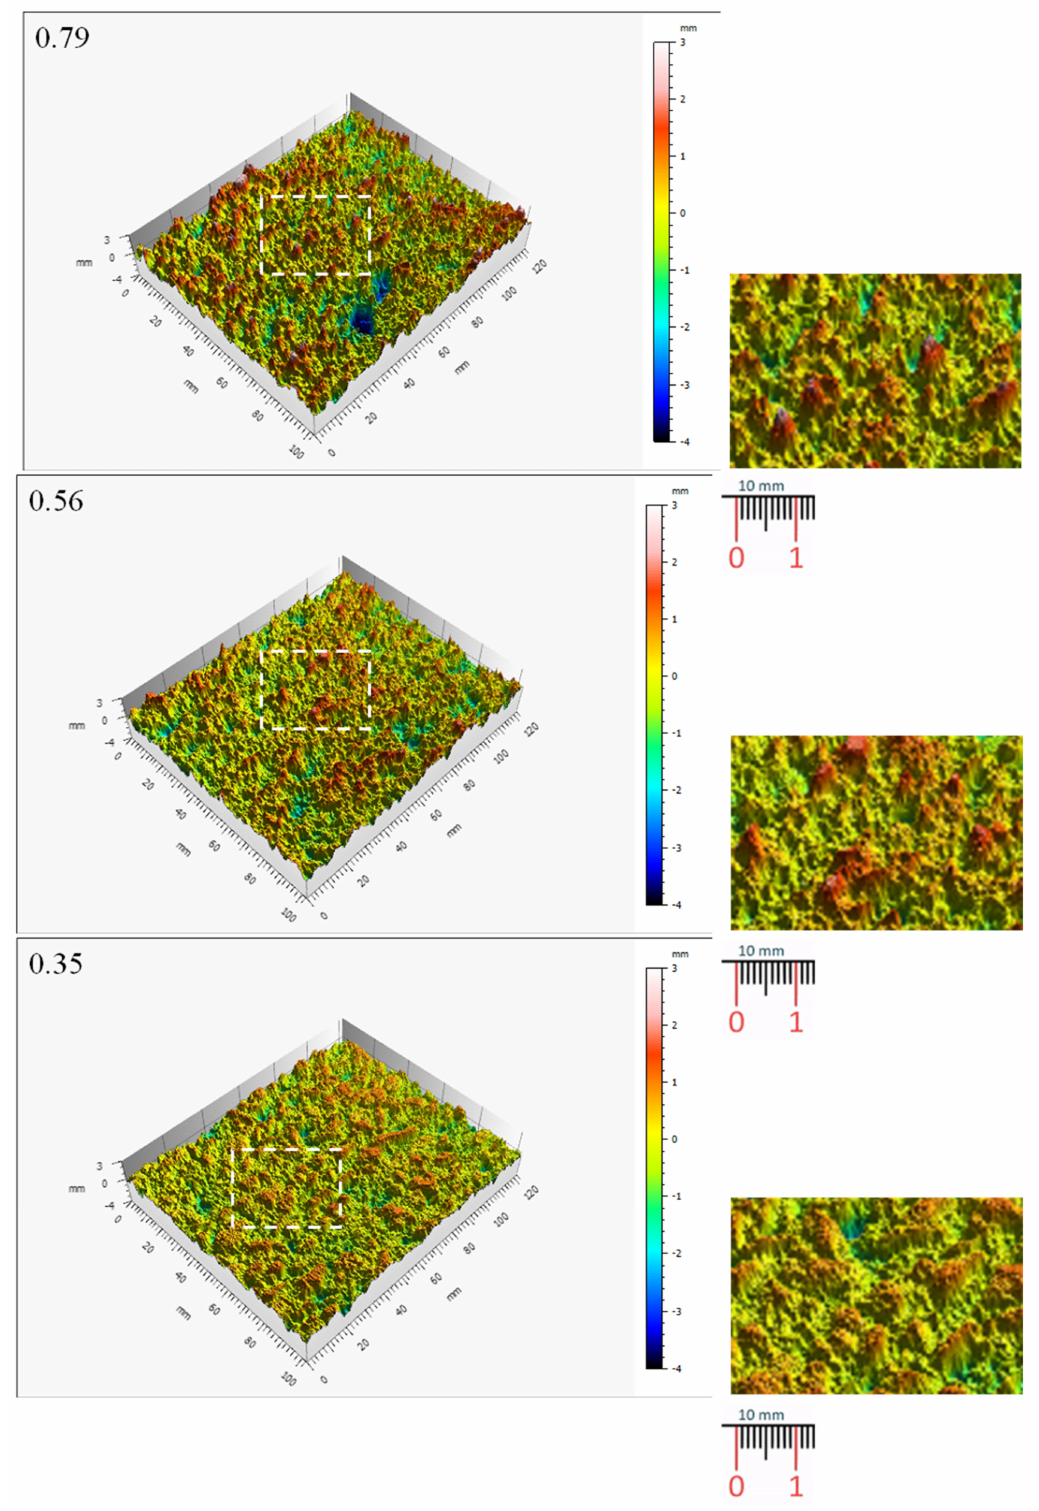
Figure 13. Isometric views of the topographical maps for three deterioration levels (from top to bottom: minimal with a coefficient of friction of 0.79; moderate 0.56; severe